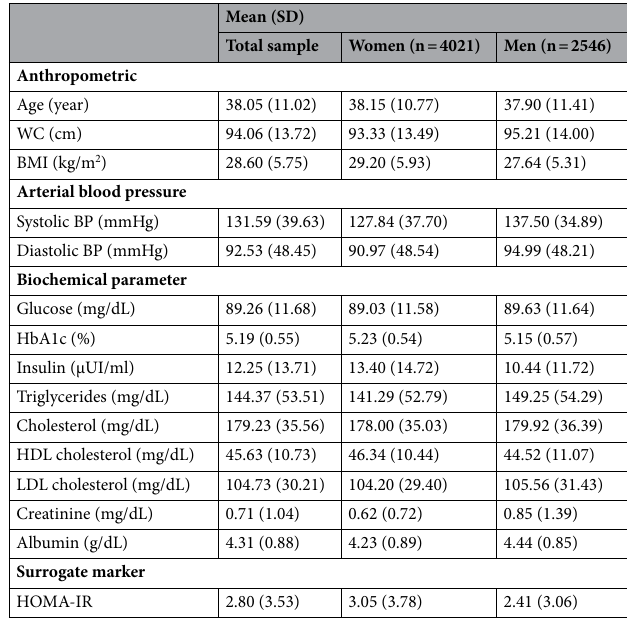
Table 1. Characteristics of adults aged 20 to 59 years from ENSANUT 2018 about components of the metabolic syndrome and other biochemical parameters (n = 6567).